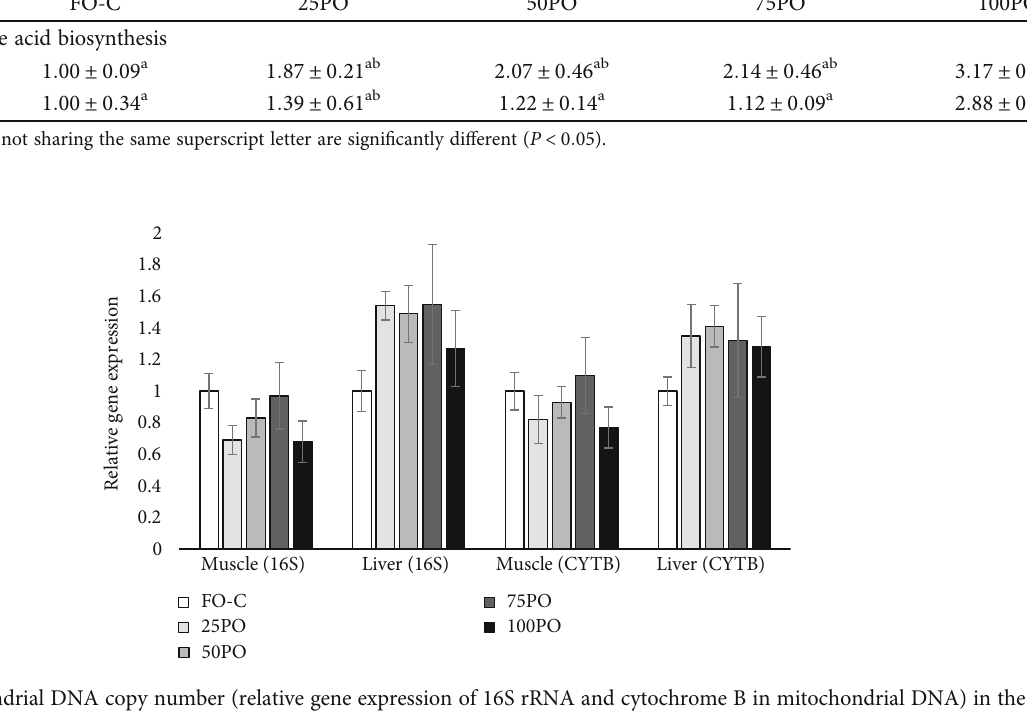
Figure 1: Mitochondrial DNA copy number (relative gene expression of 16S rRNA and cytochrome B in mitochondrial DNA) in the liver and muscle of experimental tiger pu ff